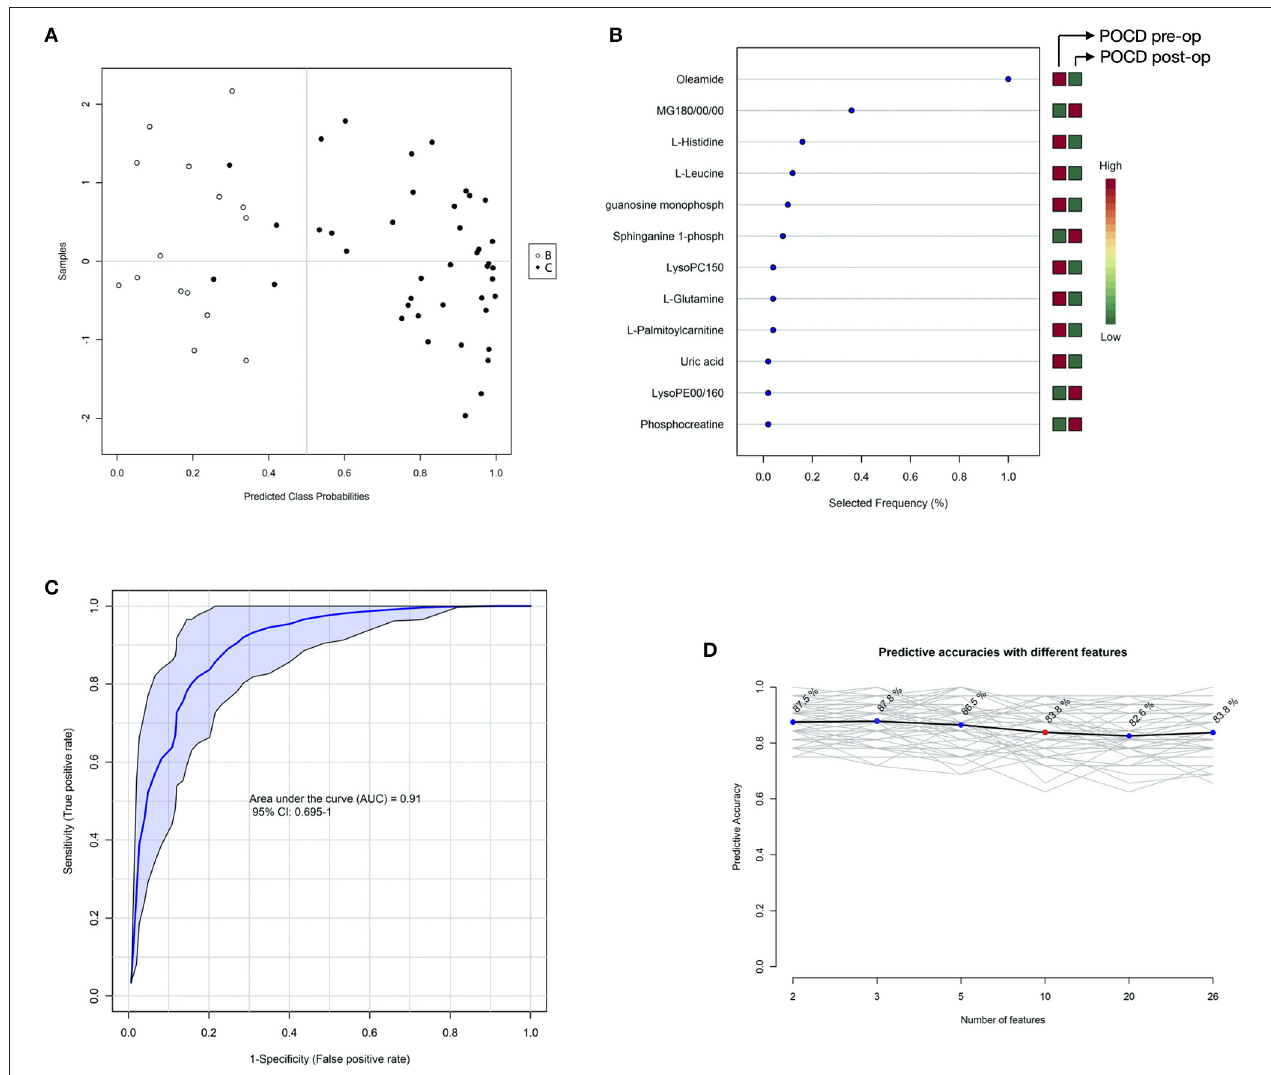
FIGURE 5 | SVM analysis of before surgery POCD and Non-POCD blood samples metabolites. (A) SVM classification of POCD and Non-POCD groups. (B) Specificity and sensitivity of the SVM model. (C) Predictive accuracies with different features in the SVM model. (D) Features’ importance ranking. The red cube represented higher metabolites detected while the green cube represented lower metabolites